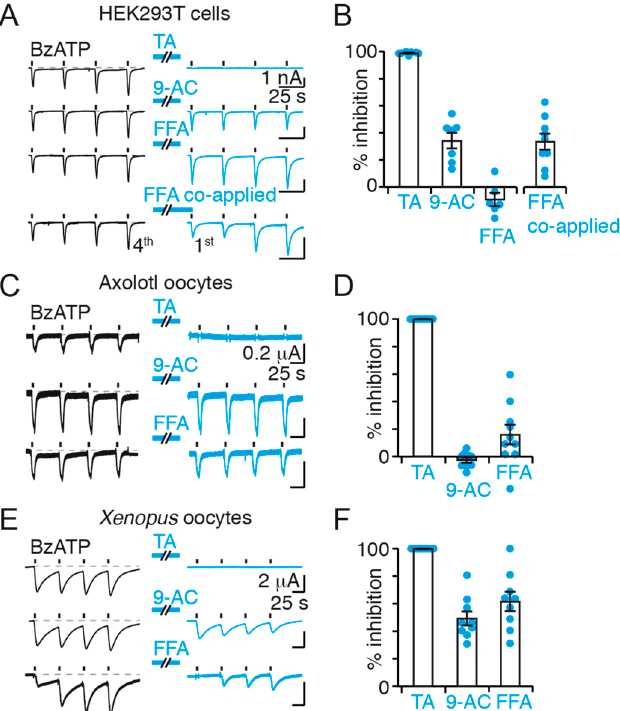
Figure 2. Functional effects of CaCC inhibitors on P2X7 currents in HEK293T cells, Axolotl and Xenopus oocytes. ( A ) Whole-cell currents evoked by repeated 2 s applications of 10 μ M BzATP (black bars) before and after 60 s perfusion of TMEM16 inhibitors (blue bars) in HEK293T cells transiently expressing rP2X7. In the case of FFA co-applied, perfusion was followed by a co-application with 10 μ M BzATP. ( B ) Summary of whole-cell inhibition ( n = 7 cells for TA, 7 for 9-AC, 6 for FFA, and 9 for FFA co-applied). Inhibition is calculated by comparing current amplitude of the fourth application before and first application after perfusion. Bars represent mean ± SEM. ( C ) Whole-cell BzATP-evoked currents recorded by TEVC of Axolotl oocytes expressing rP2X7 before and after application of TMEM16 inhibitors using the same protocol as in panel A. ( D ) Summary of inhibition in Axolotl oocytes calculated as in panel B ( n = 10 oocytes for TA, 9 for 9-AC, and 10 for FFA). Bars represent mean ± SEM. ( E ) Whole-cell BzATP-evoked currents recorded by TEVC of Xenopus oocytes expressing rP2X7 using the same protocol as in panel A. ( F ) Summary of inhibition in Xenopus oocytes calculated as in panel B ( n = 10 oocytes for TA, 9 for 9-AC, and 9 for FFA). Bars represent mean ± SEM. CaCC inhibitor concentrations were 20 µ M TA, 1 mM 9-AC and 100 µ M FFA. Data were recorded at − 60